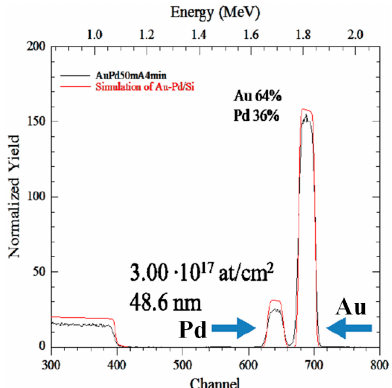
Figure 2. Experimental (black line) RBS spectrum for the AuPd film deposited on a Si slide. The peaks corresponding to the presence of Au and Pd are clearly visible. The spectrum simulation (red line) allows quantifying the number of Au atoms per cm 2 , the number of Pd atoms per cm 2 , the total thickness of the AuPd layer (48.6 nm in this case) and, so, the atomic % of Au and Pd.